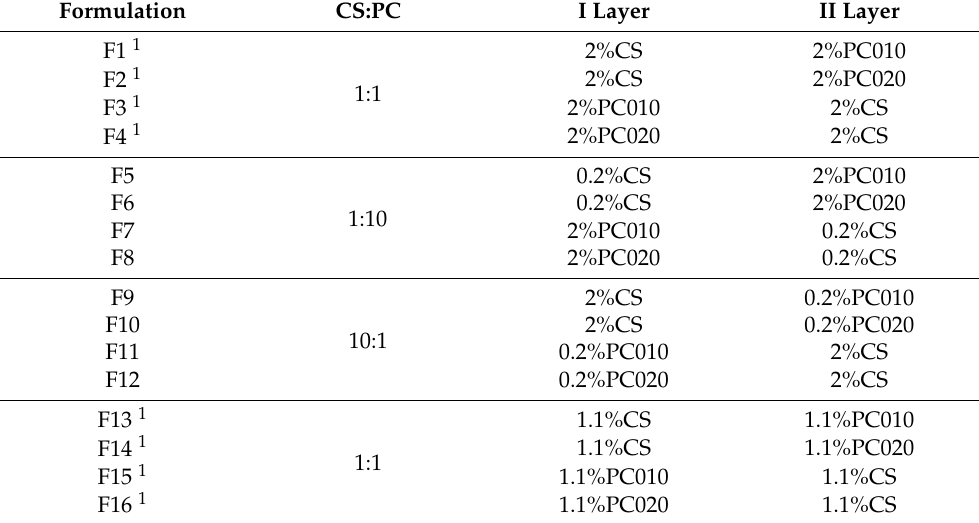
Table 2. Composition of F1–F16